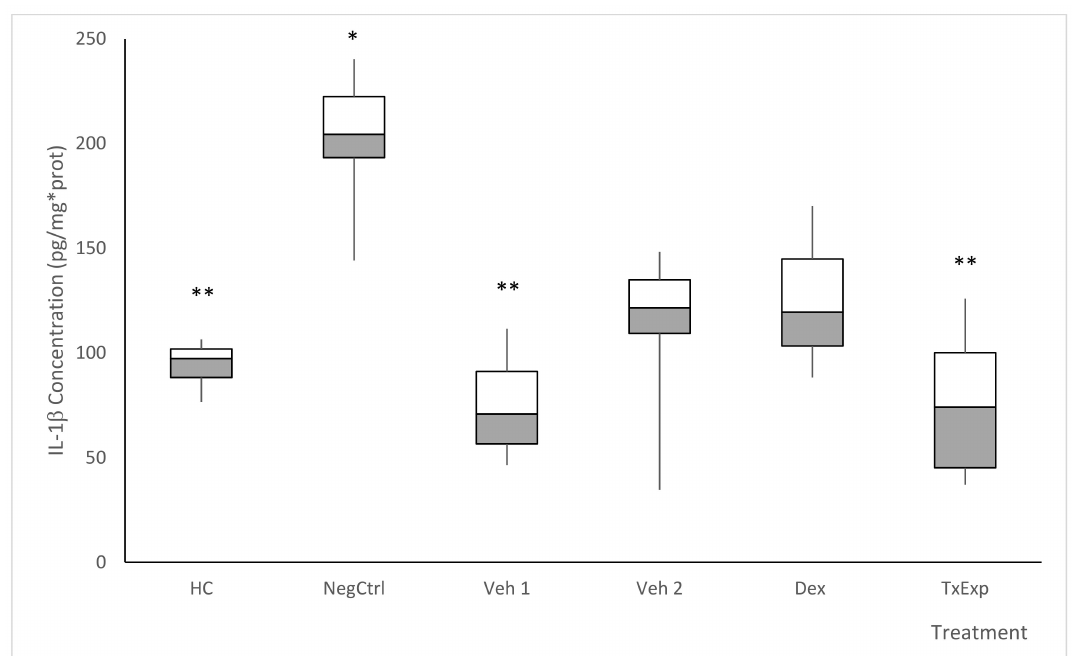
Figure 9. Tissue concentration of interleukin 1 β . The treatment groups correspond to the mice without any treatment (HC). The negative control group was administered with TPA. The Veh1 and Veh2 control groups wcorrespond to the TPA dissolution vehicle (acetone) and the treatment dissolution vehicle (cyclodextrin and Tween 20). The positive control received TPA and dexamethasone (0.5%). S. dendroideum extract is the experimental treatment. Post hoc Tukey ANOVA, n = 6, (**) p < 0.05, with respect to the negative control group and (*) p < 0.05 with respect to the baseline control group (n = 6).